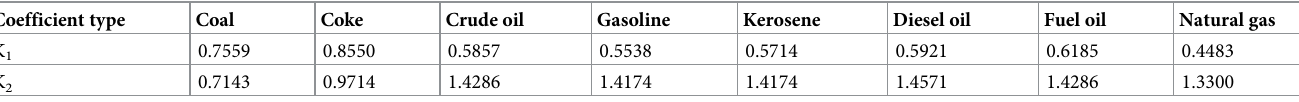
Table 1. The correlation coefficient of relevant fossil fuels.